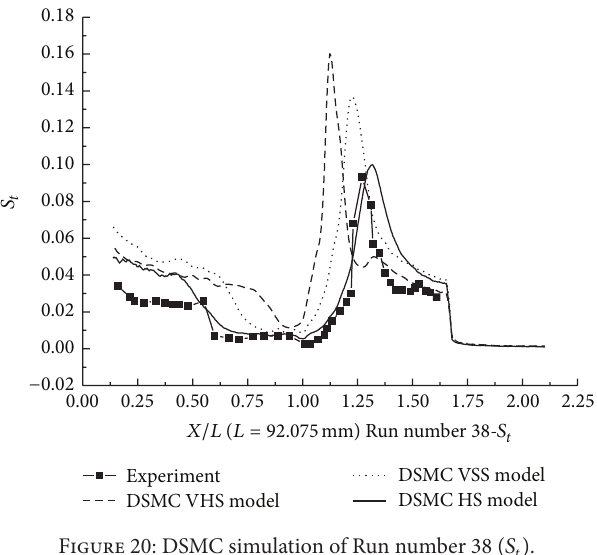
Figure 20: DSMC simulation of Run number 38 ( 𝑆 𝑡 ).